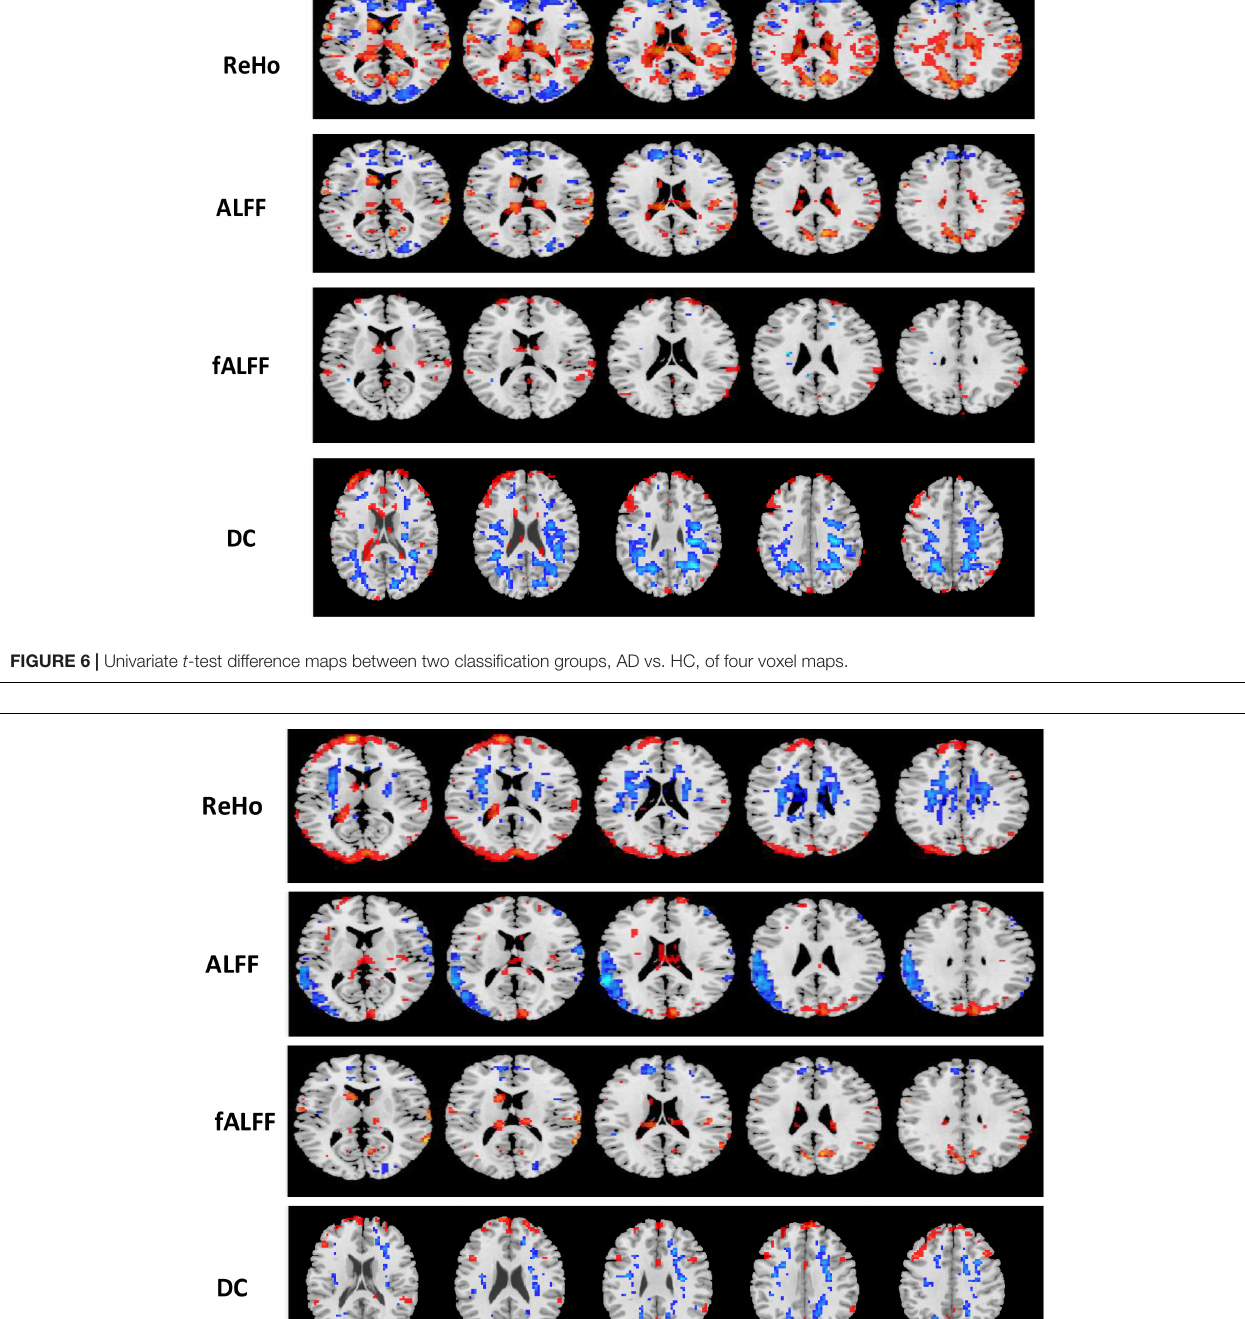
the gray matter mask from each participant with the